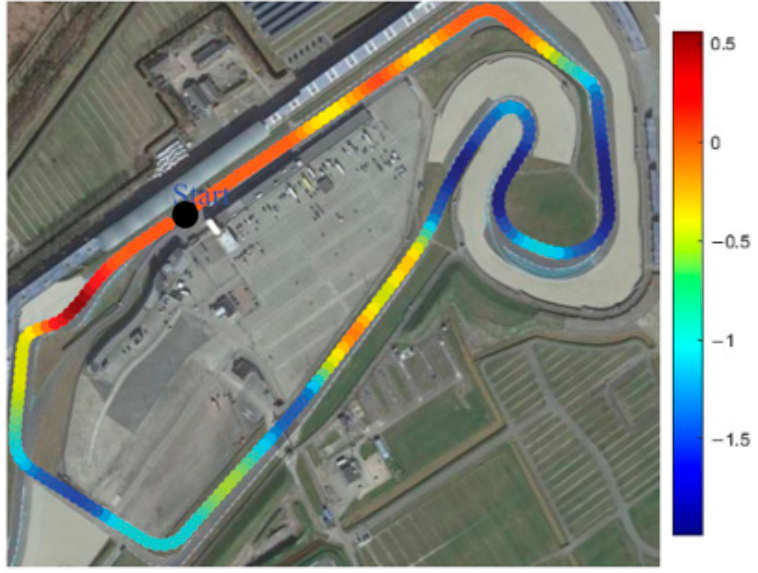
Figure 12. Elevation of TT Circuit Assen visualized on the topographical map from Ref. [23]. Optimization attempts were performed according to Equations (20)–(24). The num- ) was 232, while the initial population of GA was 580, ber of optimization variables (n var and at least 100 generations were created in each optimization case. Upper and lower boundaries were set, as indicated in Equation (25), to force the optimization to accelerate at the beginning and to stop at the end of the track. The timing of braking is fully deter- mined by the optimization boundary, which is made to avoid braking in the middle of the track; as the individuals of GA are randomized, this can be an actual scenario. boundaries = (cid:3420) z i = 1 ; i=1…4 z i = - 1 or 0 ; i=226…232